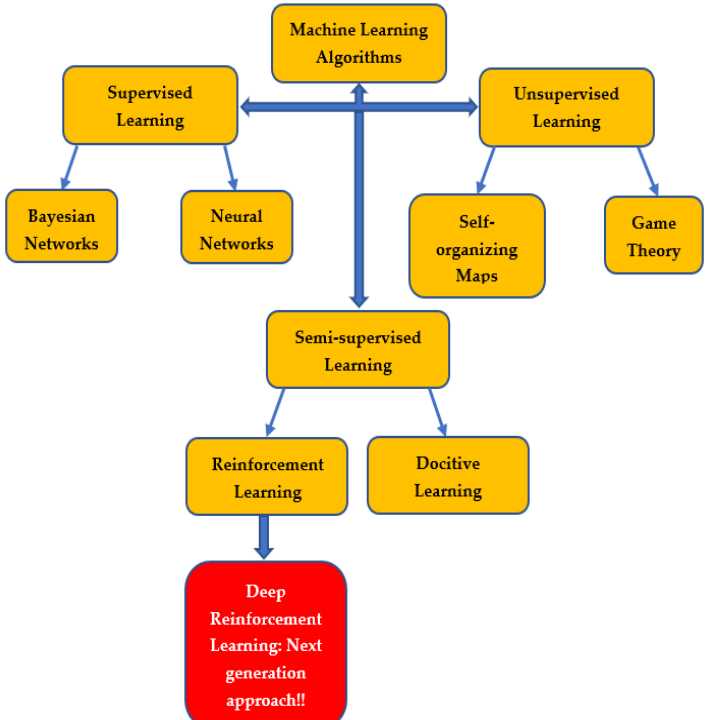
Figure 9. ML Algorithms taxonomy.